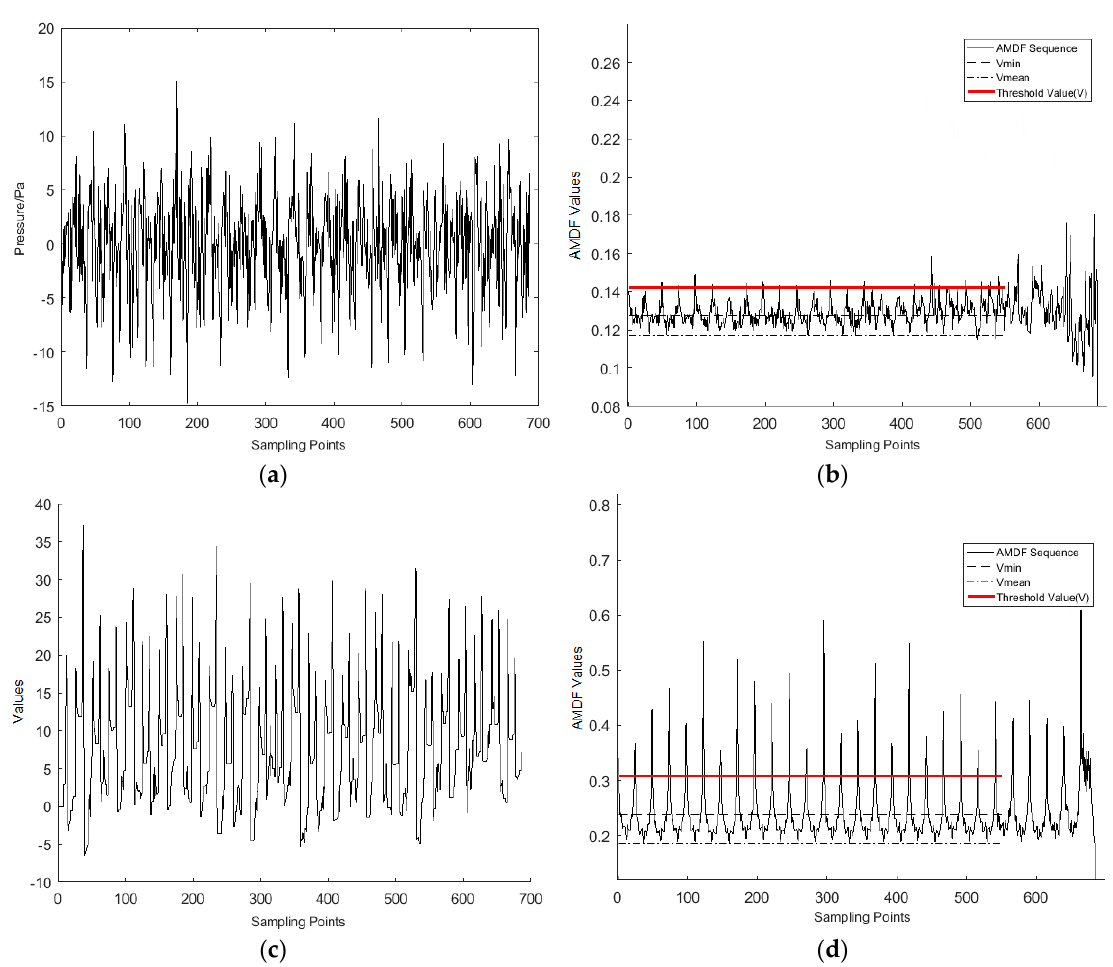
Figure 8. Simulation results of the STH-AMDF algorithm: ( a ) The original signal; ( b ) The result of AMDF of original signal and peak extraction algorithm; ( c ) The signal after STH transform; ( d ) The result of STH-AMDF algorithm.